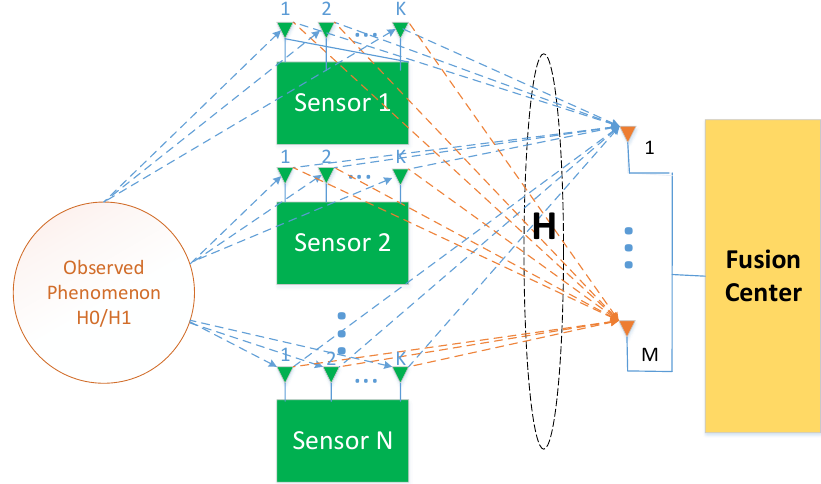
Figure 1. Schematic diagram of massive MIMO-based distributed signal detection in multi-antenna wireless sensor